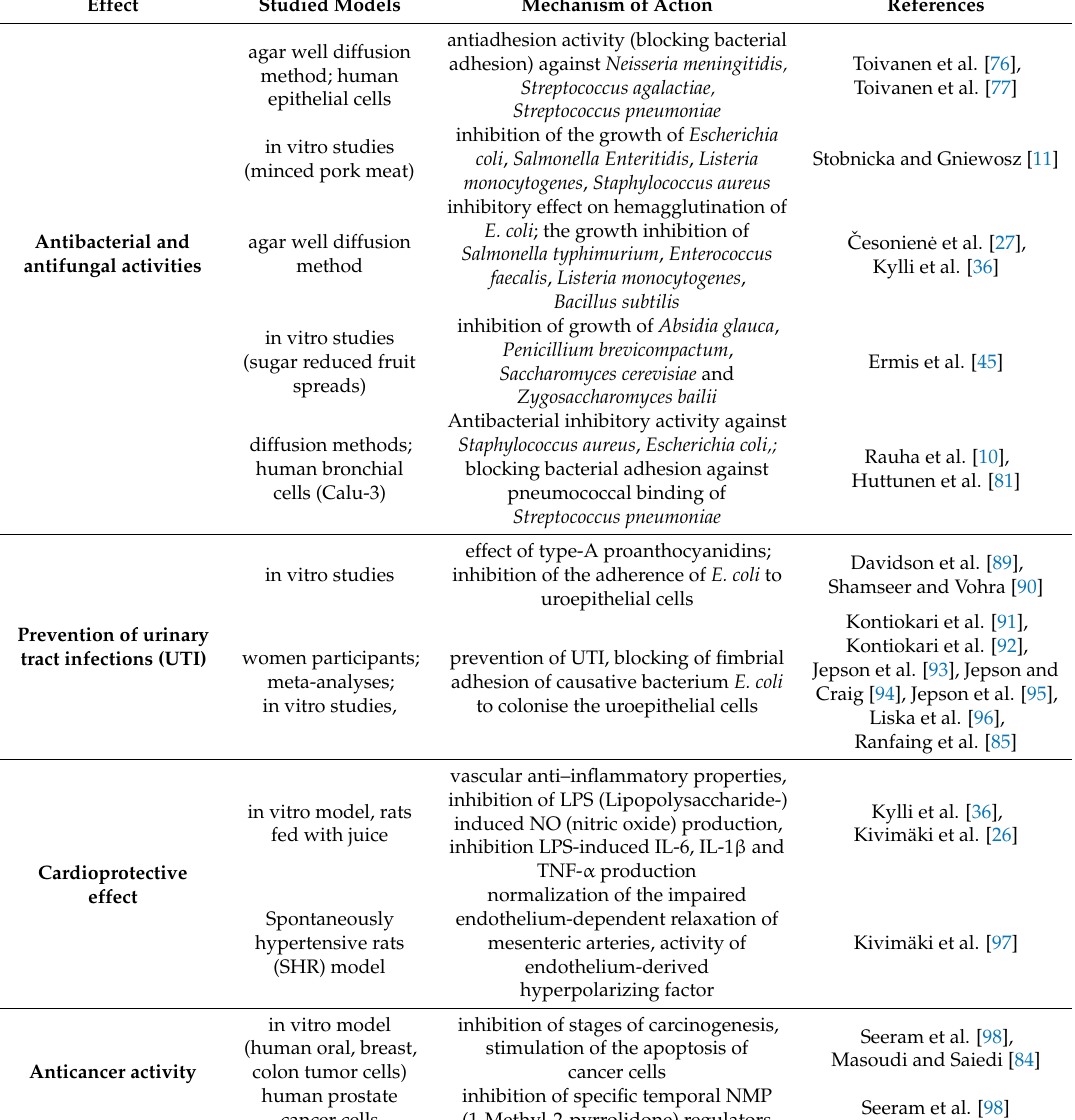
Table 4. Summarization of the evidence of European cranberry biological